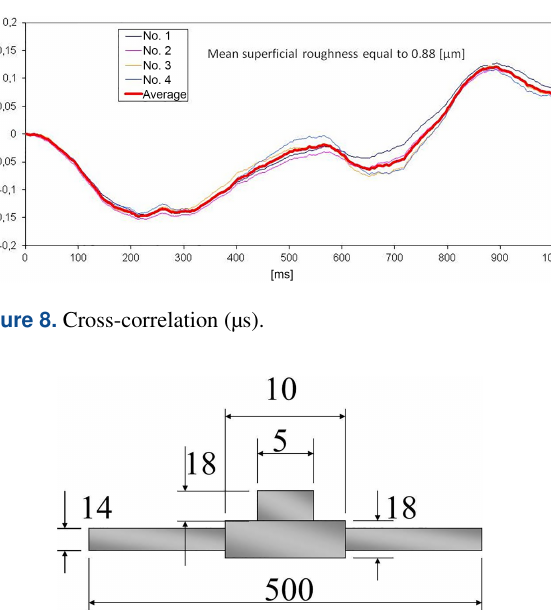
Figure 9. The shaft (dimensions in millimetres,